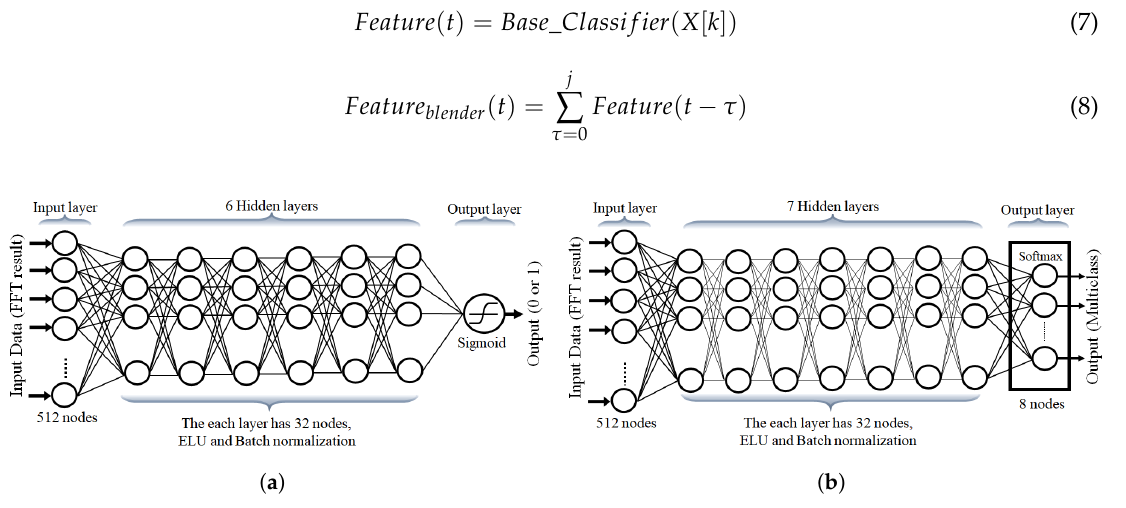
Figure 2. The binary classifier and multiclass classifier. ( a ) Binary classifier; ( b ) Multiclass classifier.